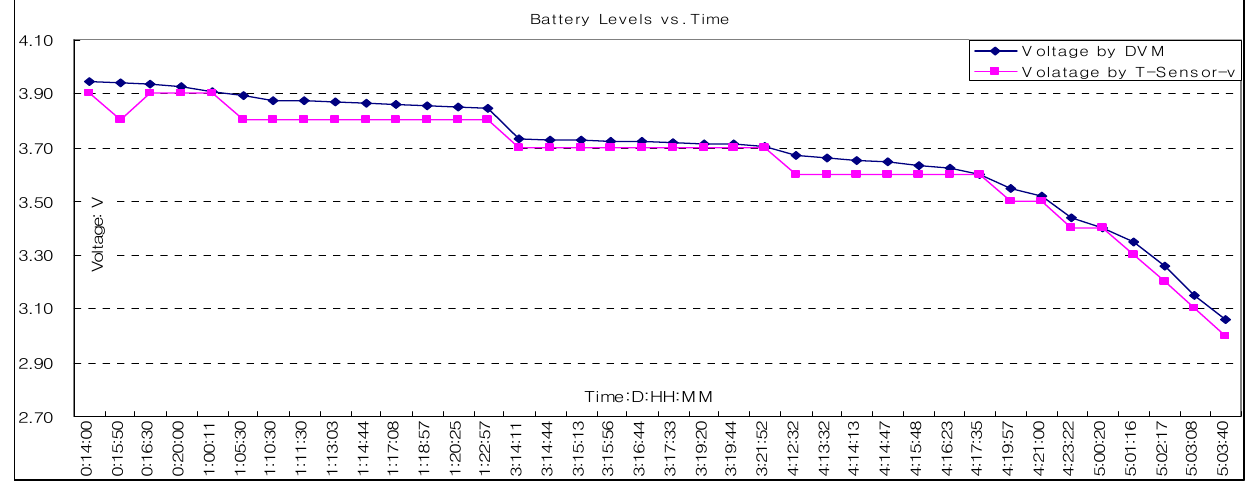
Figure 14. Battery-level (V) vs. time (D:HH:MM). Digital Voltage Meter (DVM) was used to measure the battery-level and T-Sensor-v node itself monitored its battery-level. Battery Levels vs. Time